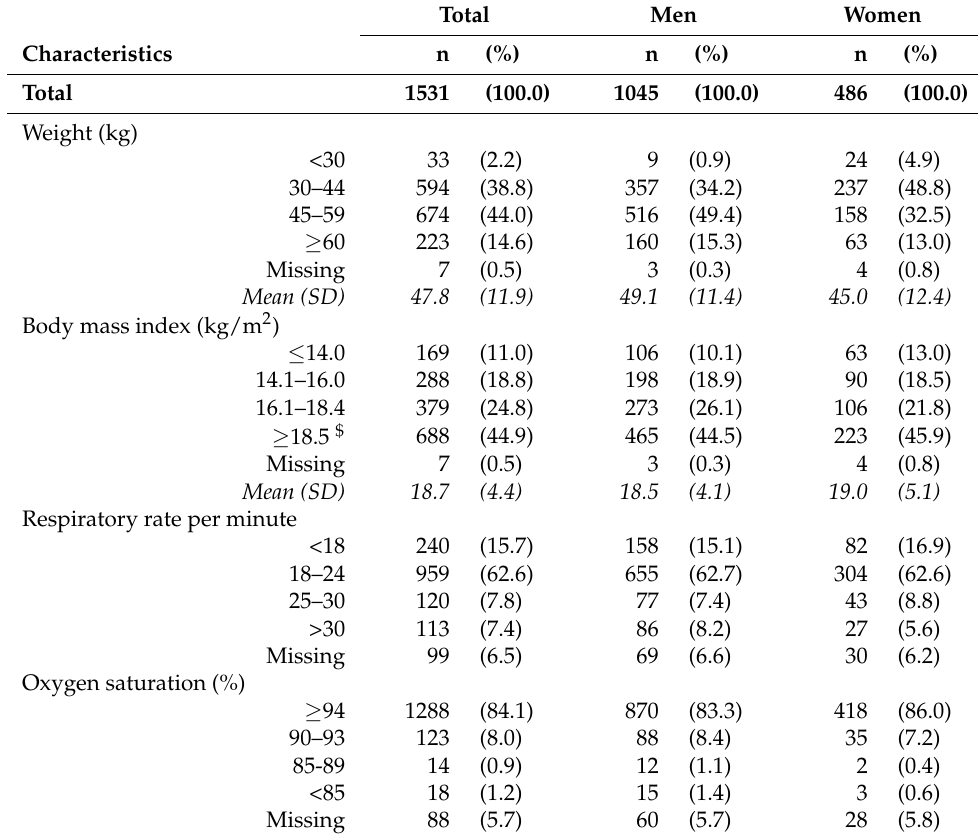
Table 4. Distribution of body mass index, respiratory rate and oxygen saturation at notification among adults ( ≥ 15 years) with TB (without known drug-resistant disease at diagnosis) screened for ‘high risk of severe illness’ from public health facilities of 16 districts of Karnataka, India, 15 October to 30 November 2020 (n = 1531) @